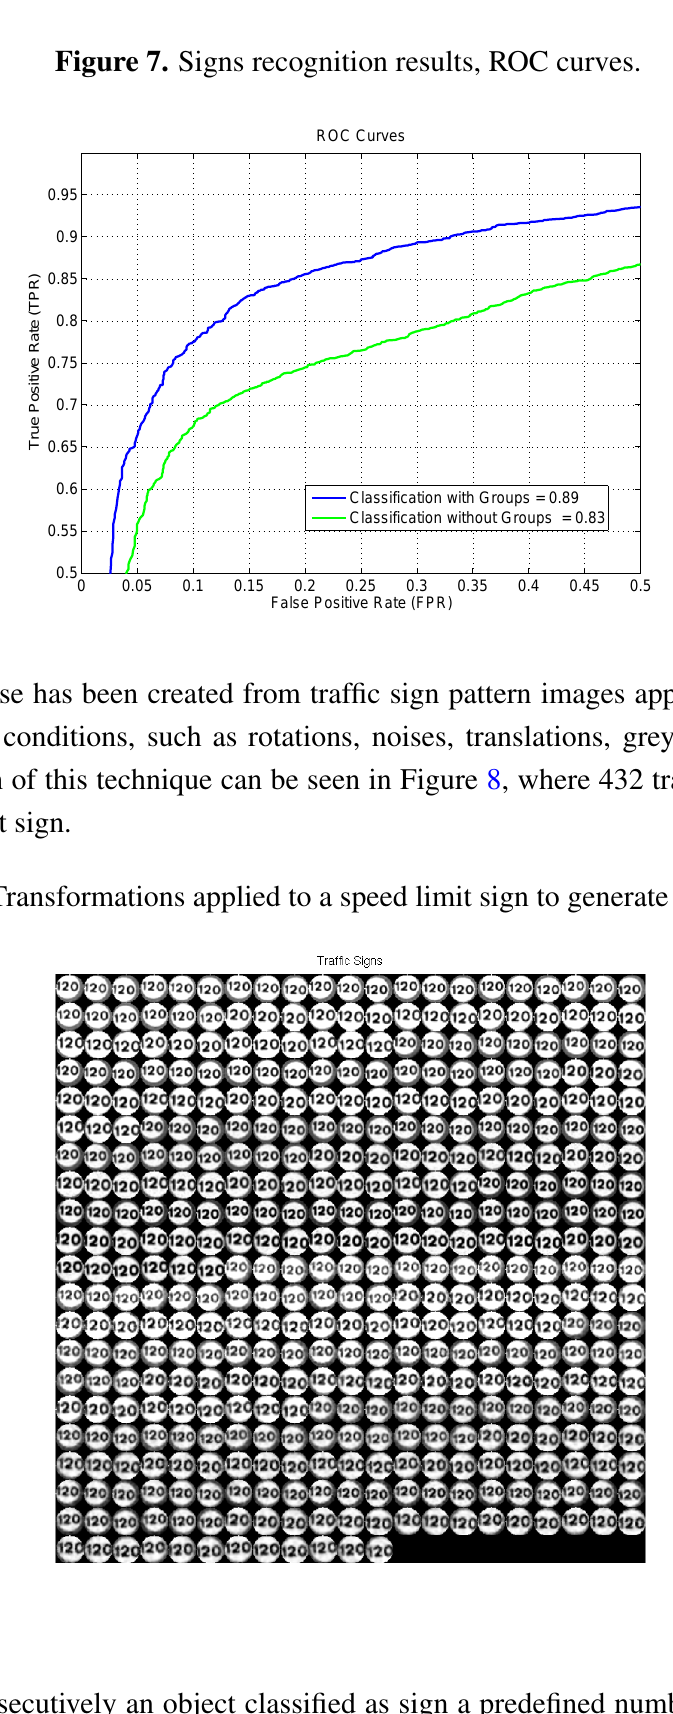
Figure 7. Signs recognition results, ROC curves.